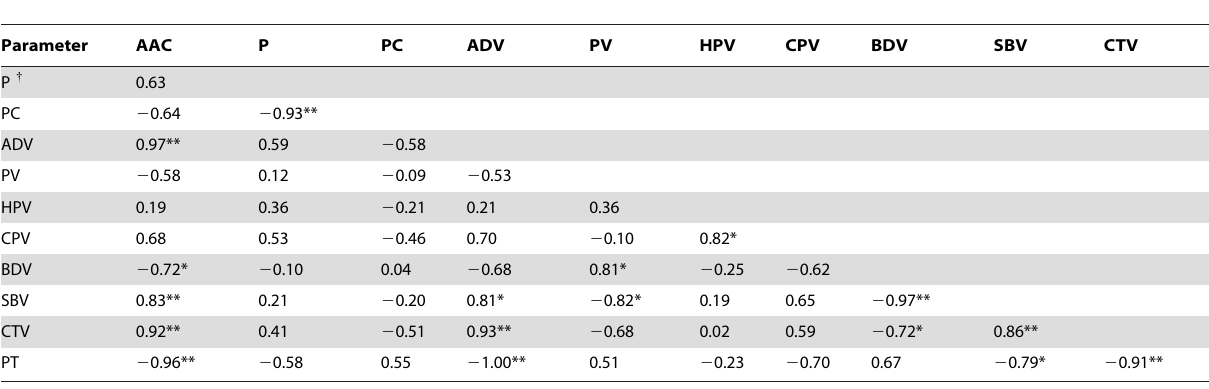
Table 2. Correlation matrix of rice eating quality